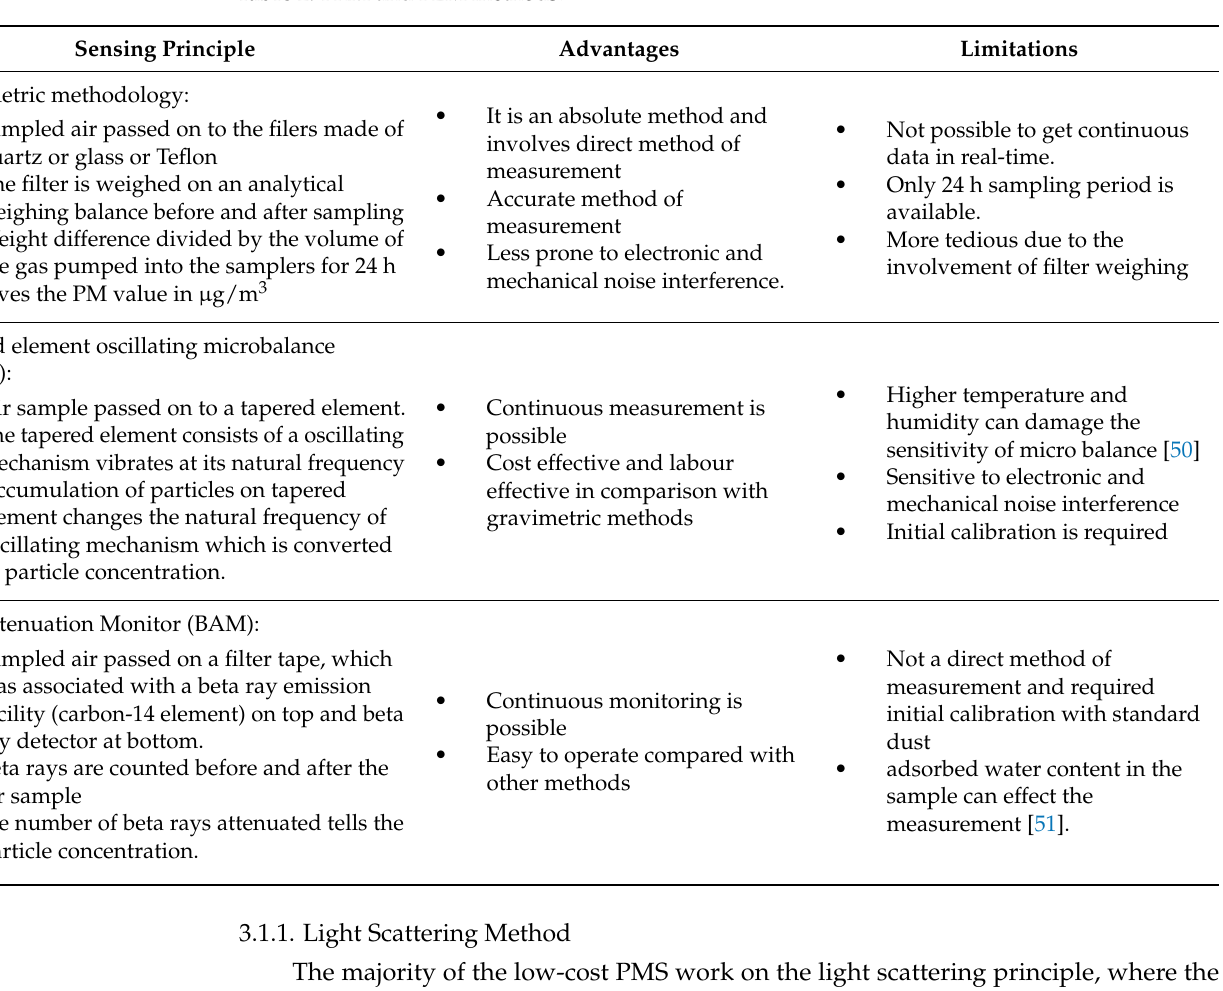
Table 2. FRM and FEM